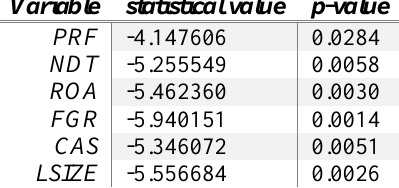
Table 1: Root test results for unit variables based on the Dickey-Fuller